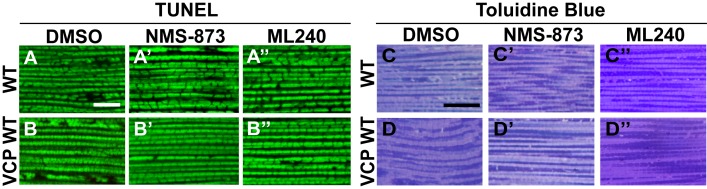
VCP inhibitor feeding does not affect muscle viability and tissue integrity in 6-day-old flies.(A–B’’) TUNEL/MitoGFP assay shows that feeding of 30 µM NMS-873 or ML240 does not cause muscle cell death in WT (IFM-Gal4 control, A–A’’) and VCP WT flies (B–B’’). Scale bar: 10 µm. (C–D’’) Toluidine Blue assay shows that feeding of 30 µM NMS-873 or ML240 does not disrupt muscle integrity in WT (IFM-Gal4 control, C–C’’) and VCP WT flies (D–D’’). Scale bar: 40 µm.